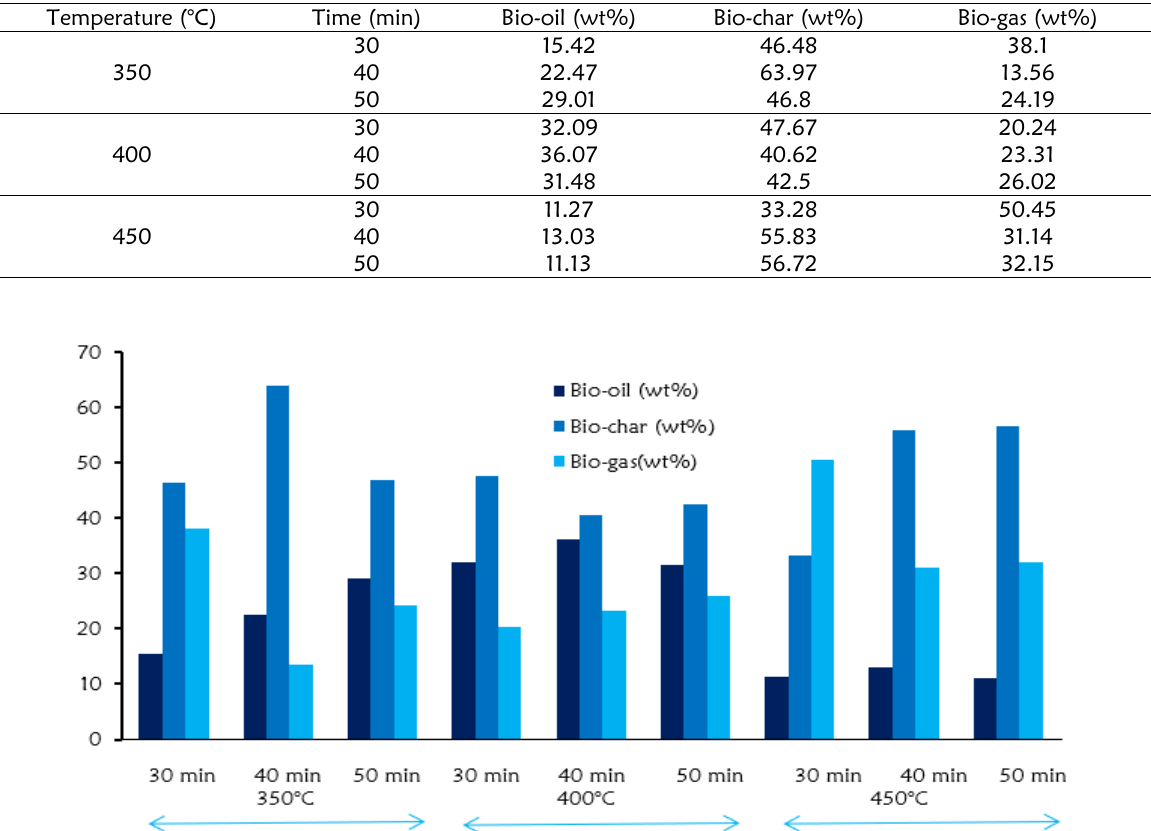
Table 2: Product yield of Palm Kernel Shell at different pyrolysis time and temperature using conventional heating.